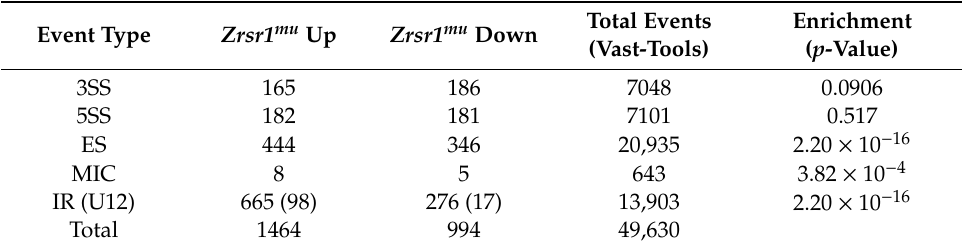
Table 1. Di ff erentially spliced events detected in the Zrsr1 mu